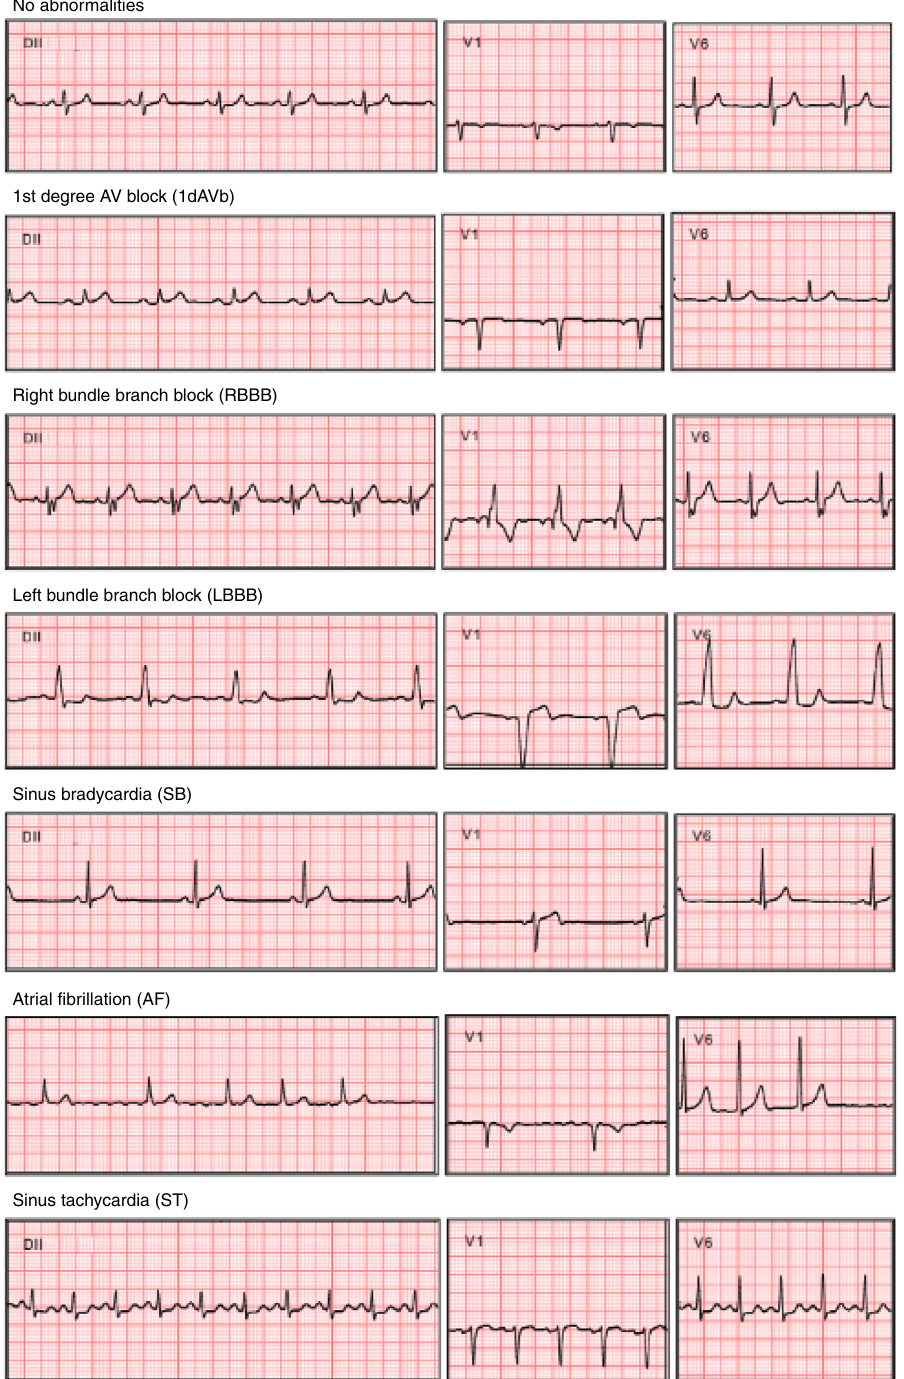
Fig. 1 Abnormalities examples. A list of all the abnormalities the model classi fi es. We show only three representative leads (DII, V1 and